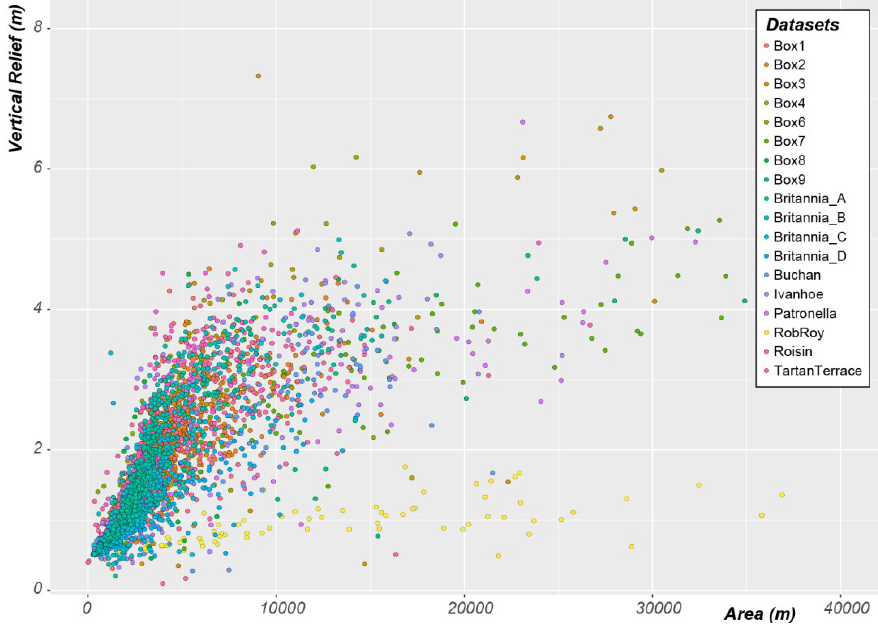
Figure 11. Vertical Relief as a function of Area in pockmarks with vertical relief lower than eight metres within the Witch Ground Basin. Note that the unusually large pockmarks existent in the Witch Ground Basin are not displayed in this figure.